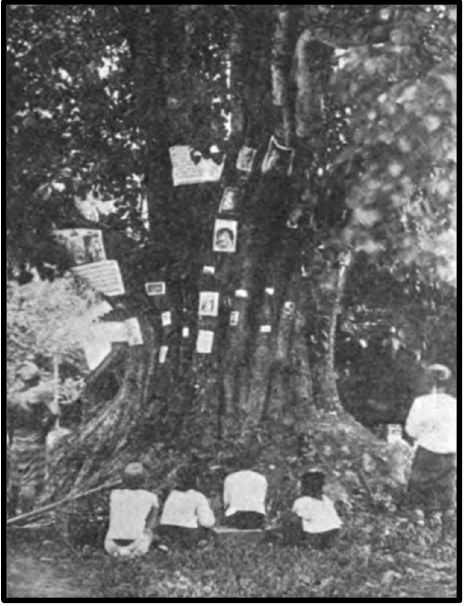
Figure 3. Ingalls’ Decorated Banyan Tree [29].